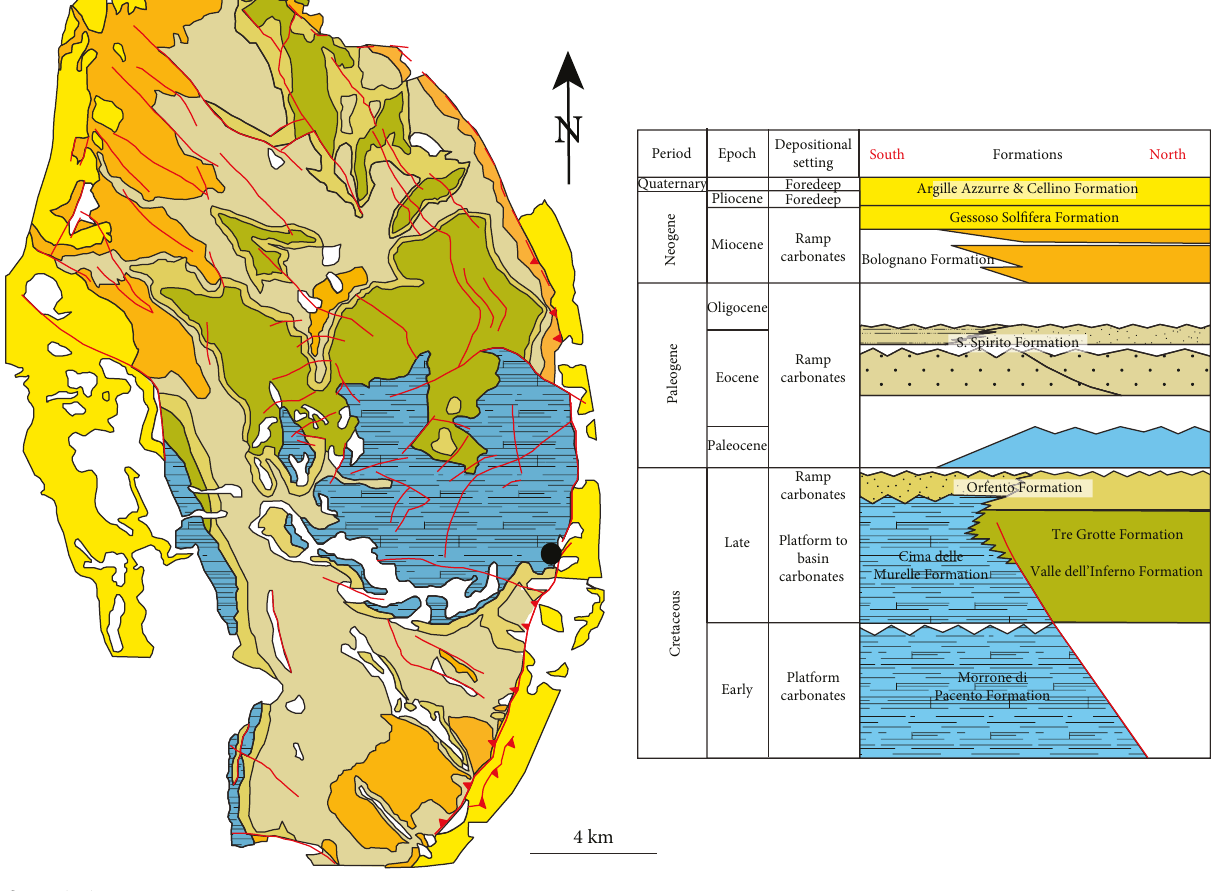
Figure 16: Geological map of Maiella with the geological units from Cretaceous until the present (modi fi ed from Di Cuia et al. [61], Aydin et al. [65], and Masini et al.